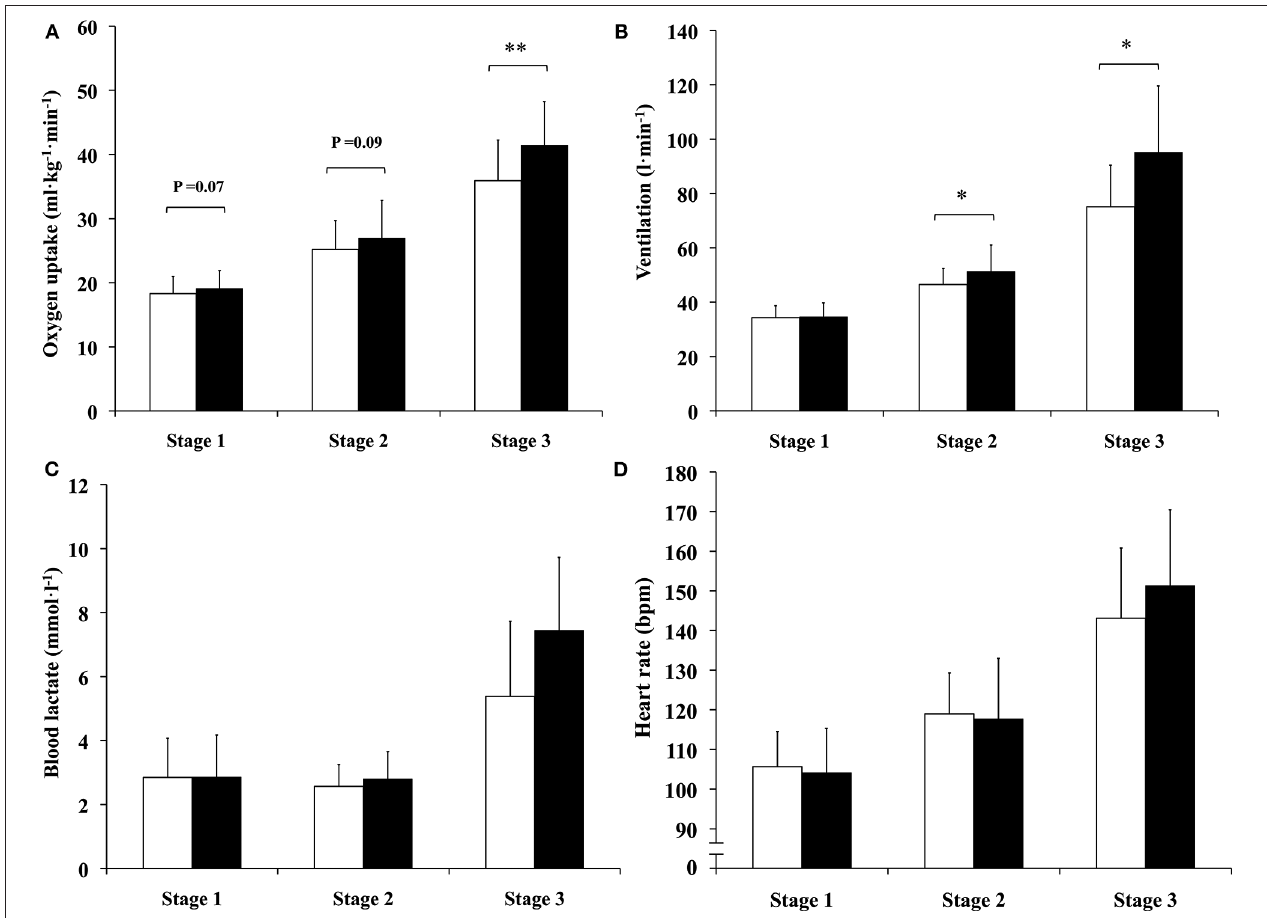
FIGURE 2 | Differences in: (A) oxygen uptake, (B) ventilation, (C) blood lactate concentration, and (D) heart rate between “kneeing” (white columns) and “knee-high” (black columns) postures during stages one, two and three (13, 22 and 34 percent of maximum sprint power output, respectively). *Statistically significant difference between “kneeing” and “knee-high” postures (* p < 0.05, ** p <